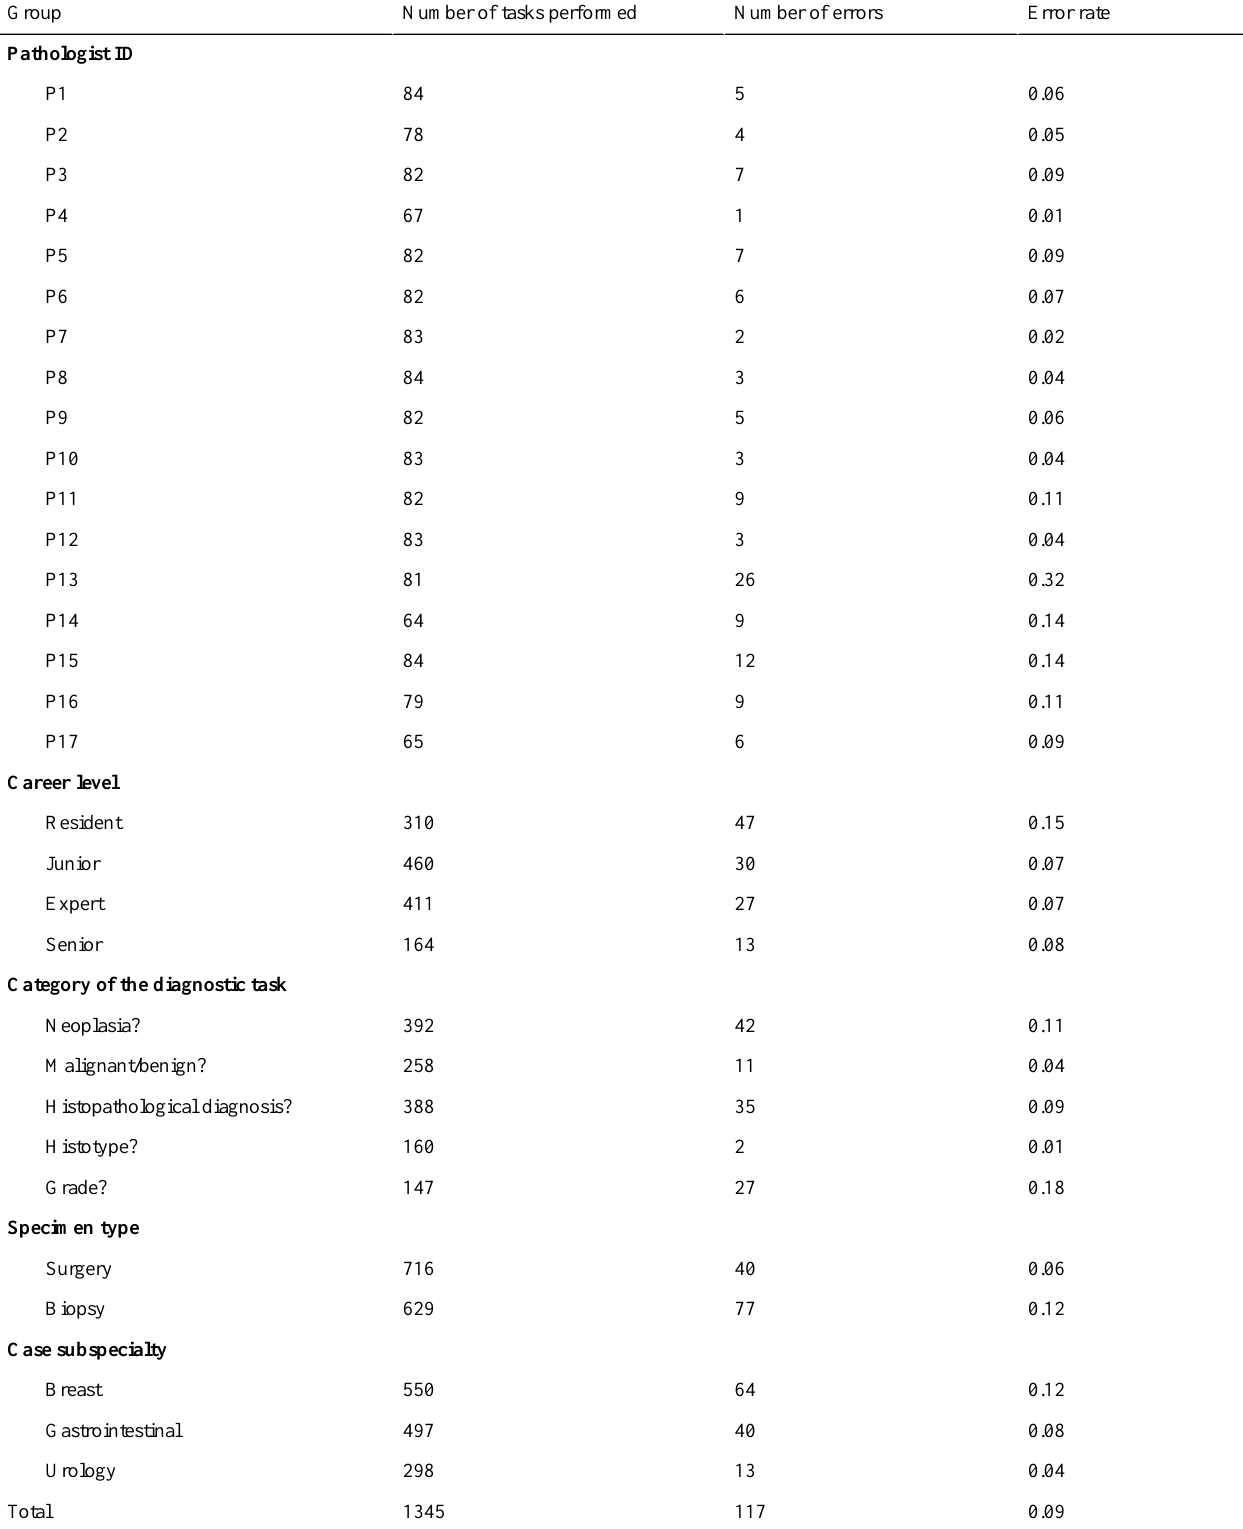
Table 1. Proportion of errors among different groups.